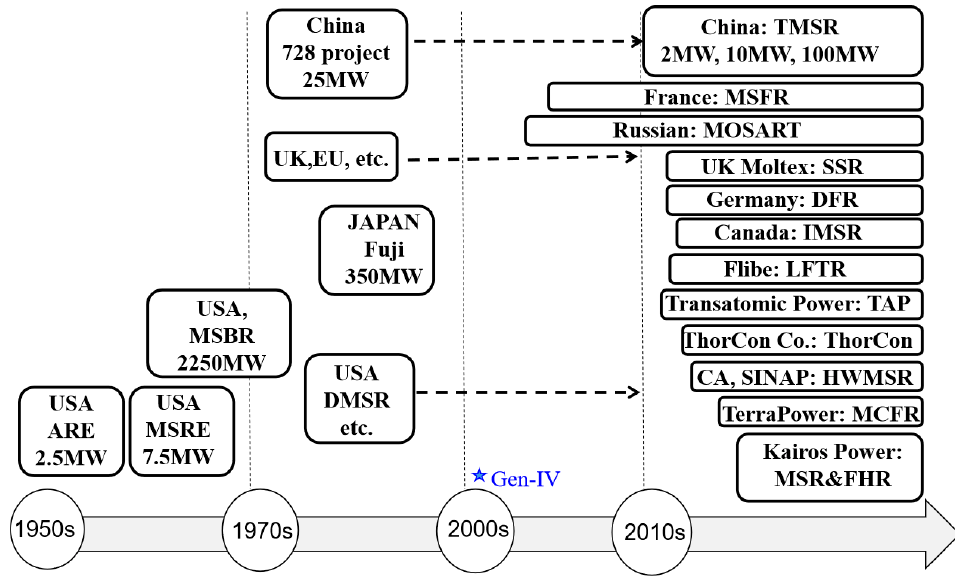
Figure 1. The research and development (R&D) activities of MSRs worldwide.